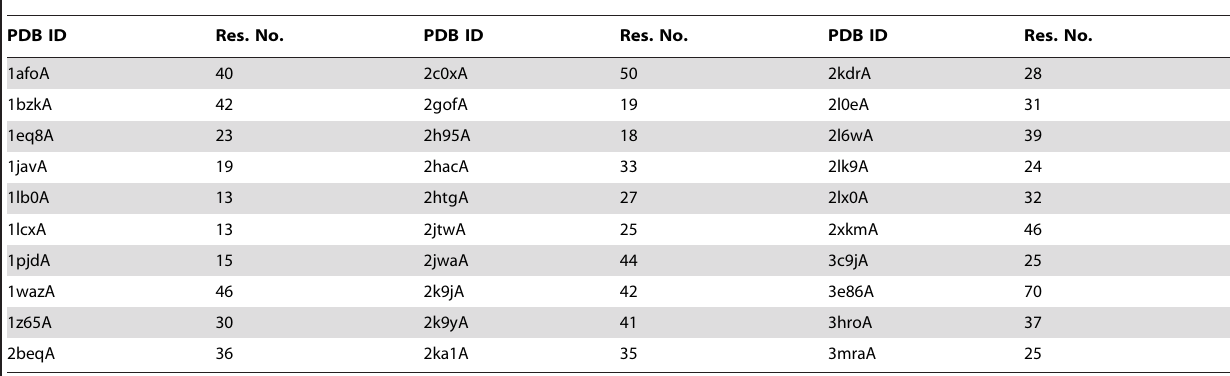
Table 3. Information of Trans-membrane protein helix.